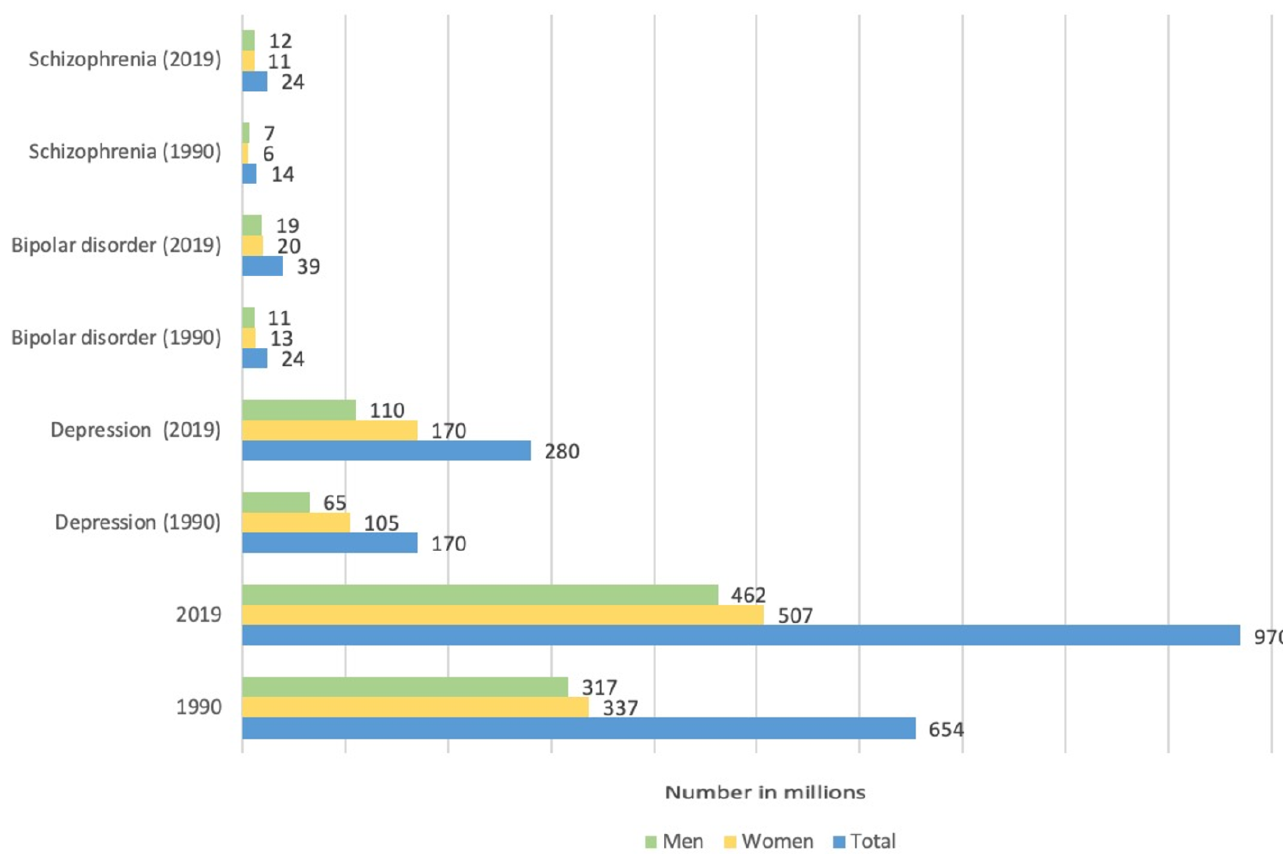
Figure 10. The incidence of mental disorders in the world from 1990 to